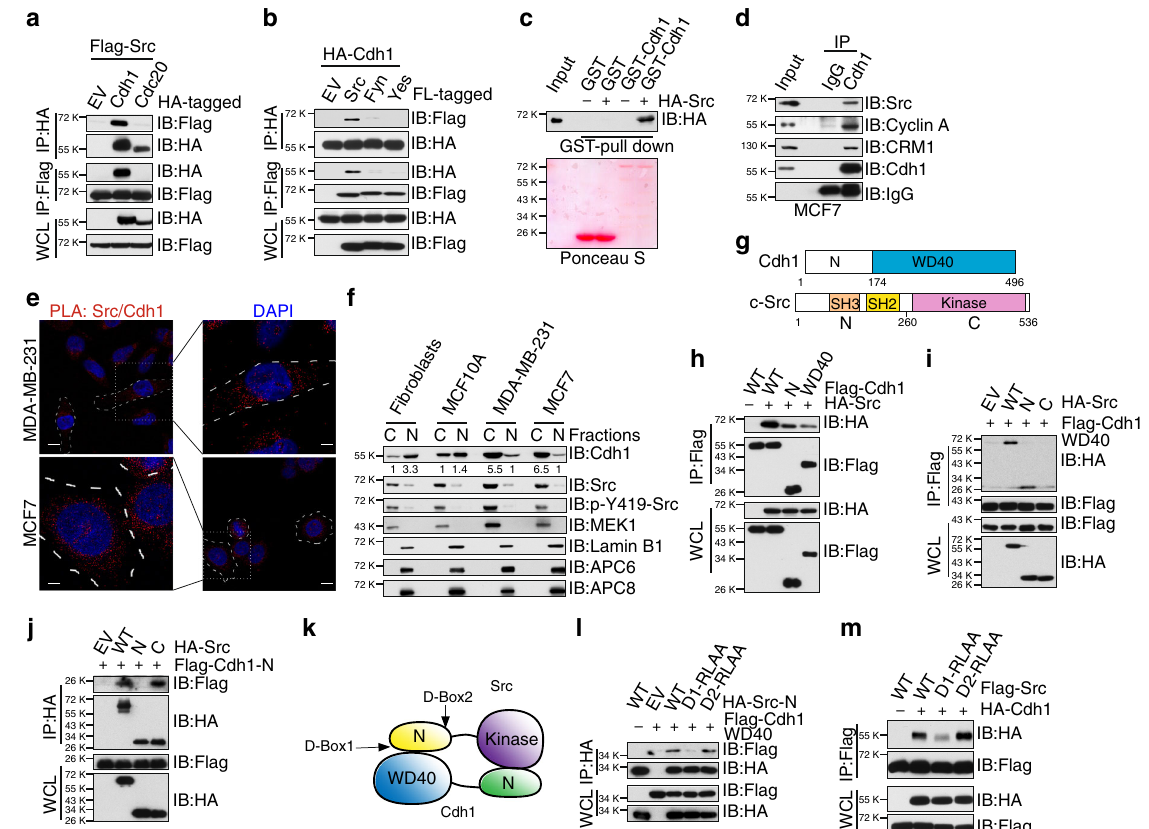
Fig. 3 Cdh1 interacts with Src in a head-to-toe manner. a Immunoblot (IB) analysis of whole-cell lysates (WCL) and immunoprecipitates (IP) derived from 293T cells transfected with Flag-Src and HA-Cdh1 or HA-Cdc20. b IB analysis of WCL and IP derived from 293T cells transfected with HA-Cdh1 and the indicated constructs. c GST pull-down analysis to determine Src bound to puri fi ed recombinant GST-Cdh1, but not the GST recombinant protein. d Endogenous Src bound to endogenous Cdh1. IB analysis of WCL and anti-Cdh1 IP derived from MCF7 cells. e Proximity ligation assay (PLA) demonstrated a cytoplasmic interaction between Cdh1 and Src proteins in MCF7 and MDA-MB-231 cells. Scale bar, 50 μ m. f IB analysis of cytoplasmic and nuclear fractions derived from the indicated cell lines. The relative band intensities of Cdh1 were quanti fi ed using ImageJ. g Schematic illustrations of the domain structures of Cdh1 and Src. h IB analysis of WCL and IP derived from 293T cells transfected with HA-Src and the indicated Flag-Cdh1 constructs. i IB analysis of WCL and IP derived from 293T cells transfected with Flag-Cdh1 WD40 domain and the indicated HA-Src constructs. j IB analysis of WCL and IP derived from 293T cells transfected with Flag-Cdh1 N terminus (aa1 – 174) and the indicated HA-Src constructs. k A schematic illustration of how Cdh1 interacts with Src in a head-to-toe manner. l IB analysis of WCL and IP derived from 293T cells transfected with Flag-Cdh1 WD40 domain and the indicated HA-Src constructs. m IB analysis of WCL and IP derived from 293T cells transfected with HA-Cdh1 and the indicated Flag-Src